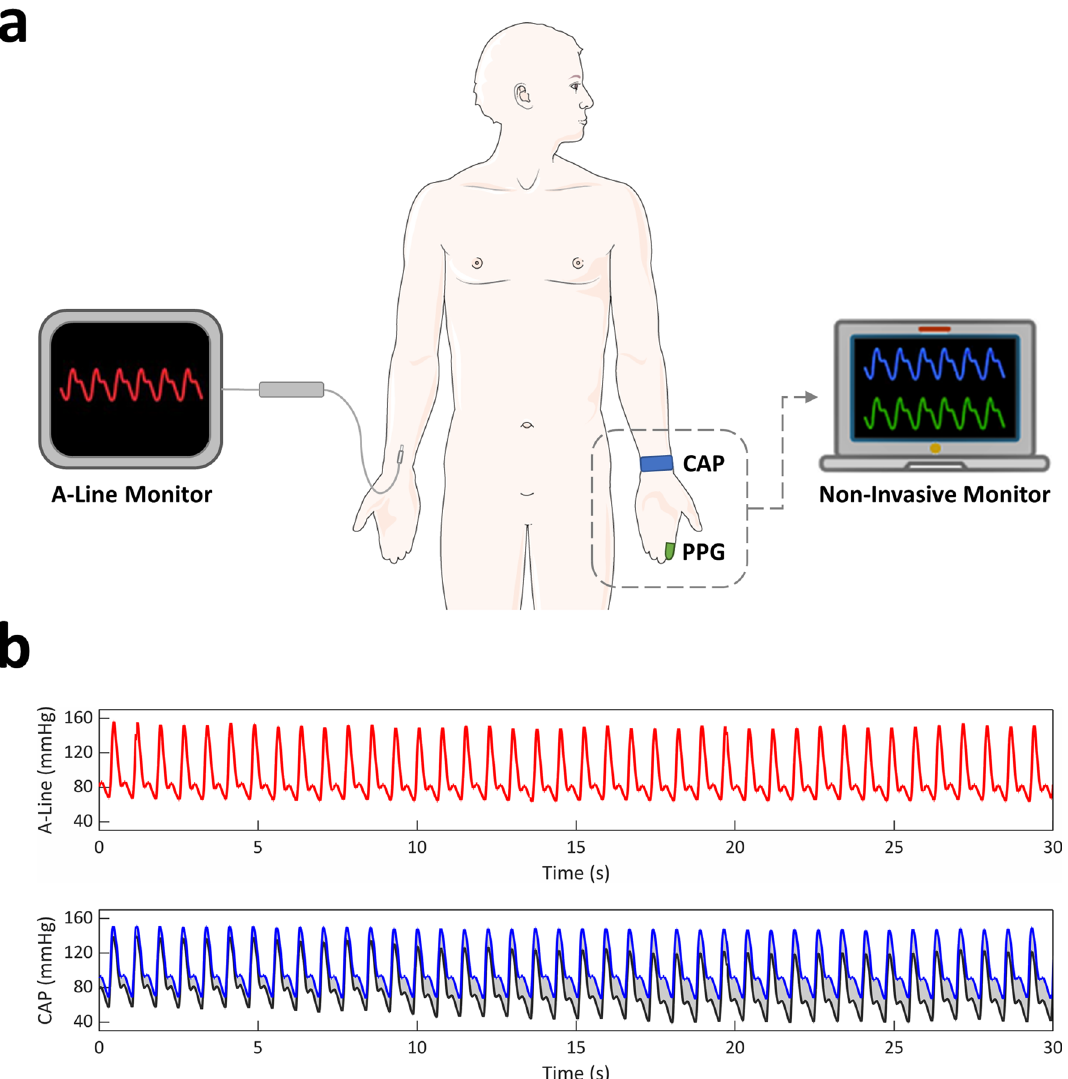
Figure 1. Overview of DTT approach. ( a ) Inpatient BP data was acquired using an invasive radial A-line and contralaterally-placed noninvasive CAP or PPG sensor. ( b ) BP signals from noninvasive sensors were processed using our DTT algorithm to obtain measurements comparable to those of the A-line. Gray shaded region indicates the offset between raw (gray line) and DTT-processed (blue line)